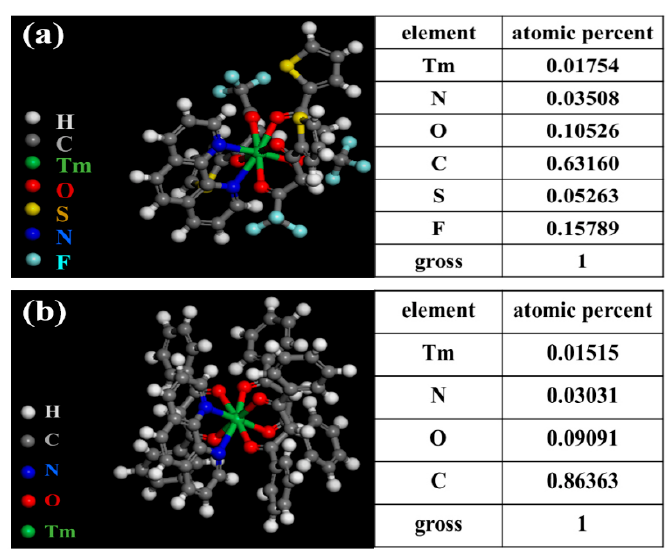
Figure 1. Predicted structure and EDS of ( a ) Tm(TTA) 3 phen; ( b ) Tm(DBM) 3 phen.